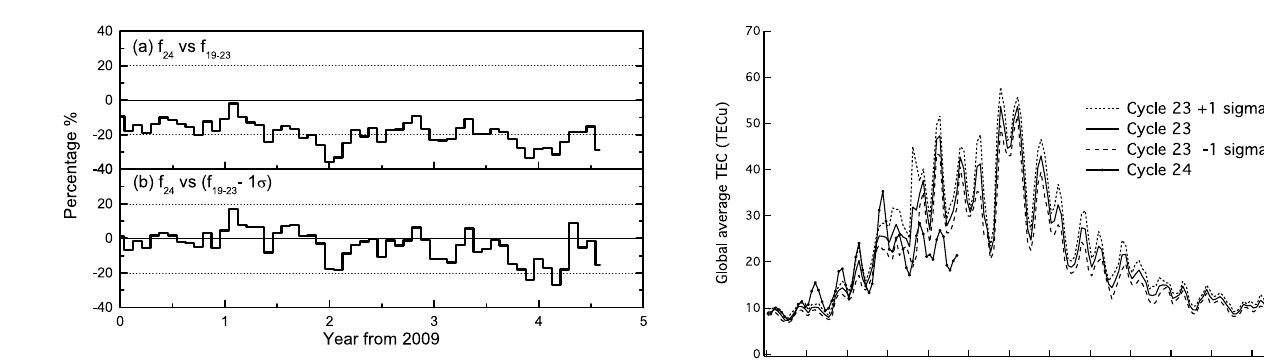
Figure 3. The percentage deviation of SC24 fo F2 ( f 24 ) from recent solar cycles, (a) compared to the mean value of SC19–23 ( f 19 − 23 ) and (b) compared to minus one standard deviation about the SC19– 23 mean value ( f 19 − 23 − 1 σ ).